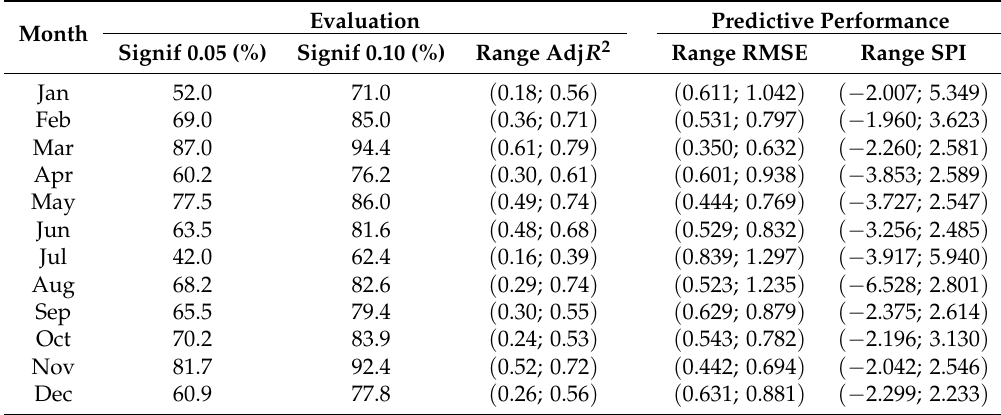
Table 4. Model evaluation and predictive performance: summary of the results obtained in each grid cell ( signif 0.05 and signif 0.10 represent the percentage of predictors in the best model that are individually significant at level α = 0.05 and α = 0.10 of the t-test, respectively; adjR 2 and RMSE range are the minimum and maximum values of Root Mean Square Error obtained throughout the spatial domain; the SPI range contains the minimum and maximum values of the observed Standardized Precipitation